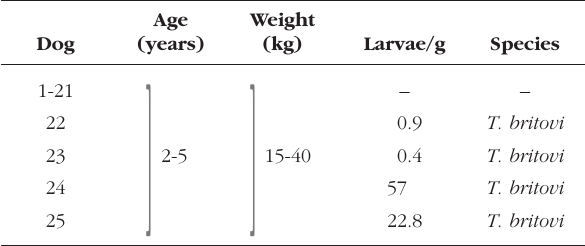
Table I. – Results of the search and identification of Trichinella larvae in muscles samples collected on 25 dogs from Mitrovica, north